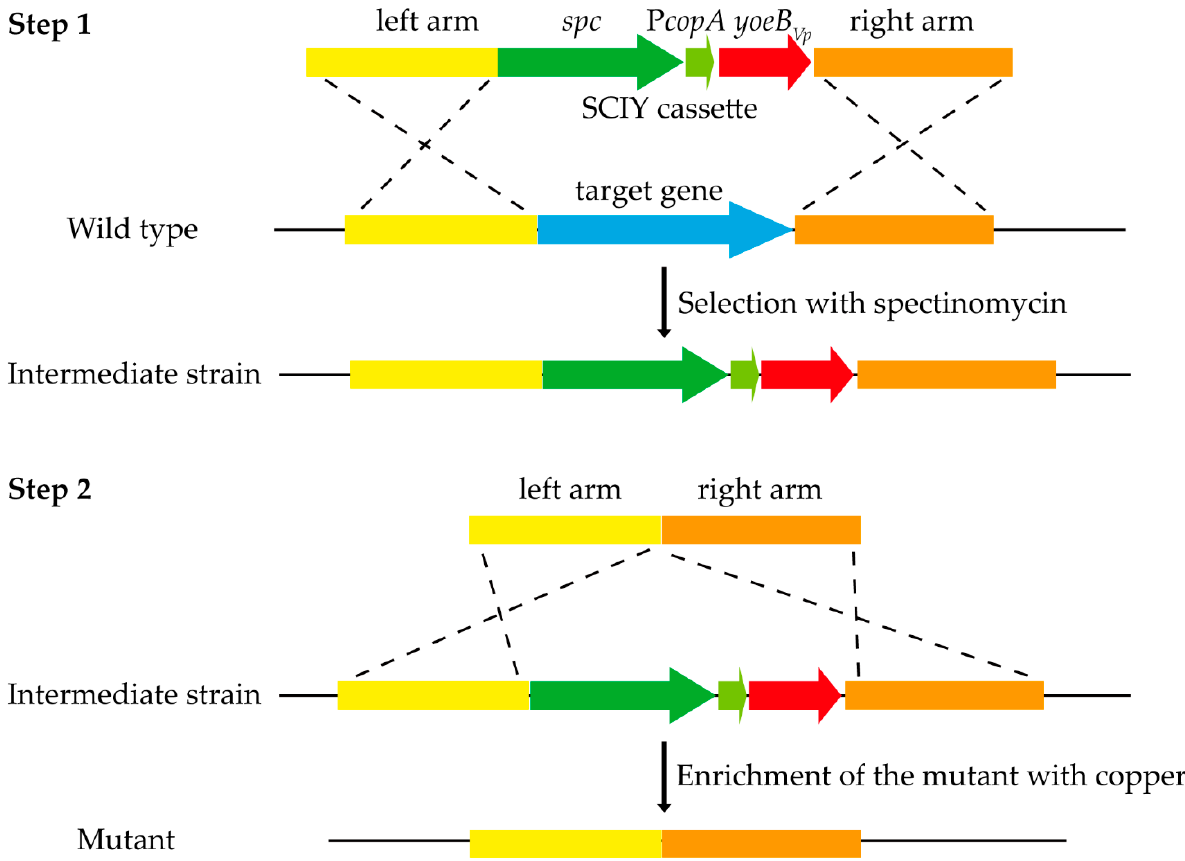
Figure 4. Schematic representation of the two-step markerless gene deletion method in S. suis . In the first step, the target gene was replaced by the SCIY cassette. The intermediate strain was selected with spectinomycin. In the second step, the markerless gene deletion mutant was generated. Growth of the intermediate strain was inhibited by copper, whereas the mutant was tolerant to copper. The medium was supplemented with copper for the enrichment of the mutant.